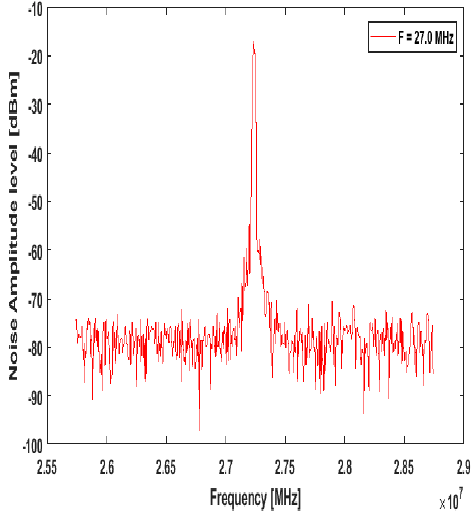
Figure 17. Waveform at 27 MHz.